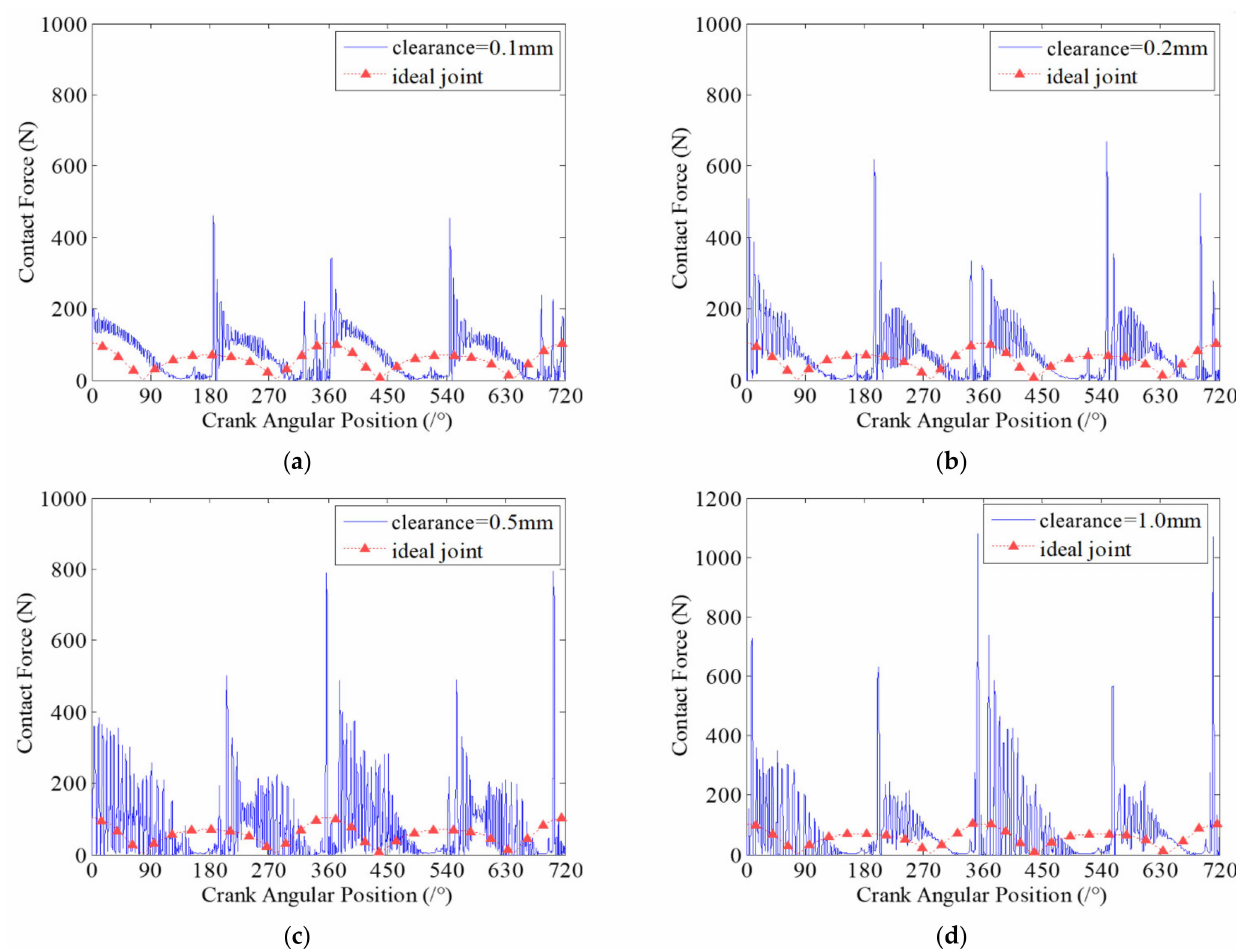
Figure 8. Contact forces in revolute clearance joint A for different clearance sizes. ( a ) 0.1 mm; ( b ) 0.2 mm; ( c ) 0.5 mm; ( d ) 1